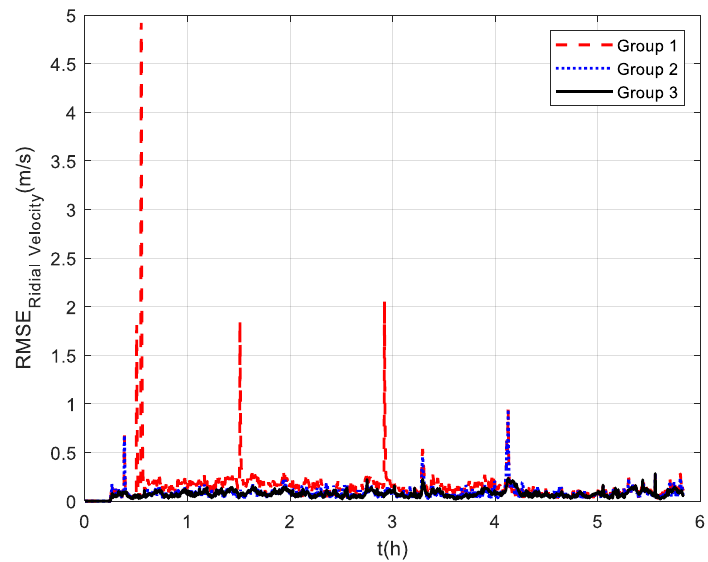
Figure 13. Velocity errors at high latitudes.